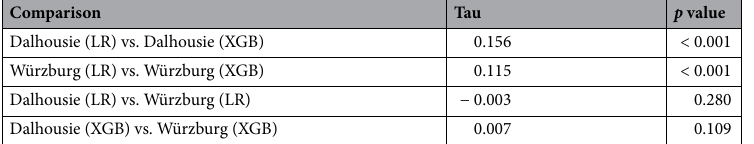
Table 5. Feature importance comparisons. Logistic regression (LR) coefficients and XGBoost (XGB) feature importance were saved at each fold of cross-validation within the site-level analyses. We computed the mean values of these coefficients (feature importances) over the cross-validation folds for each feature in the dataset (i.e. each locus of variation). We then compared the feature importance/coefficient values between models within a site (i.e. Dalhousie (LR) vs. Dalhousie (XGB)) and between sites within a model (i.e. Würzburg (LR) vs. Dalhousie (LR)). Where the comparison was made between the LR and XGB classifiers, LR coefficients were first transformed by taking their absolute